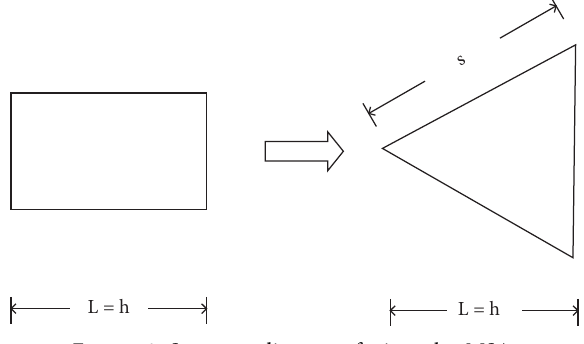
Figure 8: Structure diagram of triangular MSA. Table 6: Resonant frequency of triangular MSA.